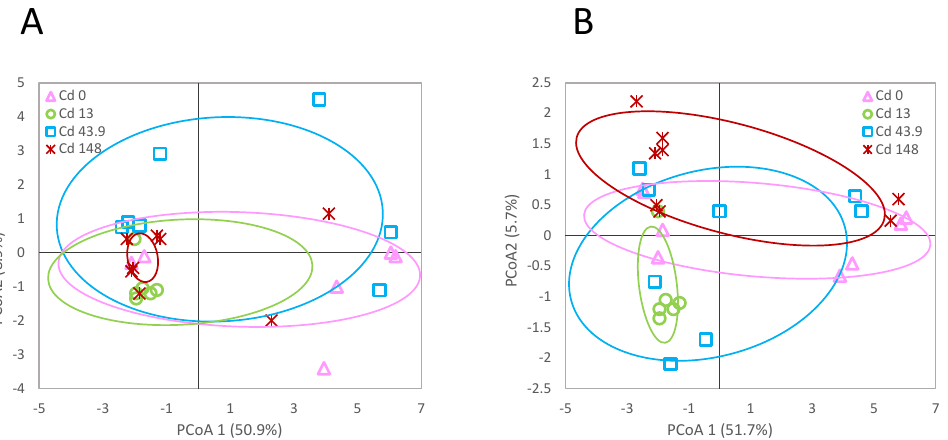
Figure 3. Principal Coordinate Analysis of the detected methylation ( A ) and genetic polymorphism ( B ) site patterns at the sequence 5 ′ -CCGG-3 ′ for L. rubellus exposed for 140 days to a control and 13, 43.9 and 148 mg/kg per dry weight soil Cd throughout development from early juvenile stage.